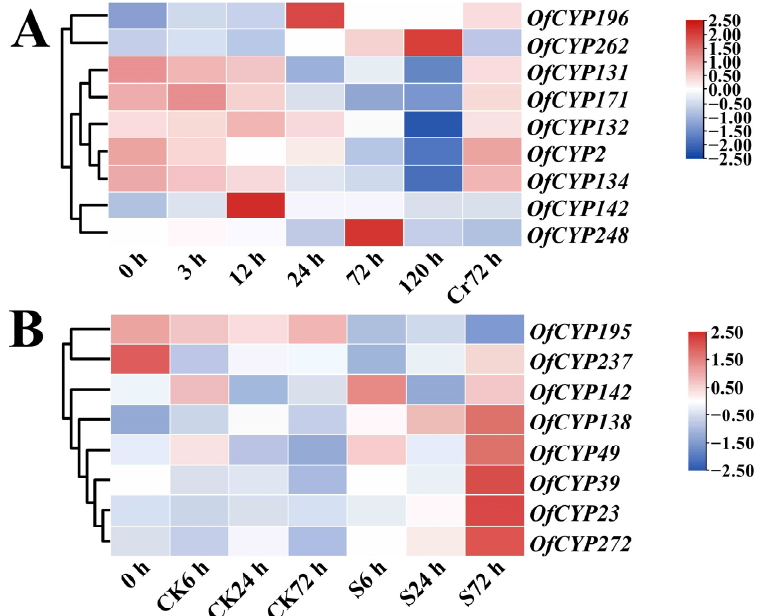
Figure 6. Expression levels of key OfCYP s screened in response to cold and salt stress conditions. ( A ) Expression profiles of OfCYP s in response to cold stress. 0 h, 3 h, 12 h, 24 h, 72 h, and 120 h represent the different times that the cold treatment was maintained. The Cr72 h represents recovery for 72 h after a 120-h cold treatment. ( B ) Expression profiles of OfCYP s in response to salt stress. S0, S6, S24, and S72 denote salt stress for up to 0 (control), 6, 24, and 72 h, respectively. The FPKM values for OfCYP s in leaves were obtained from the sweet osmanthus RNA-seq data under cold and salt stress conditions (Tables S5 and S6) and were normalized by log 2 transformation. The heatmap was generated by TBtools software.